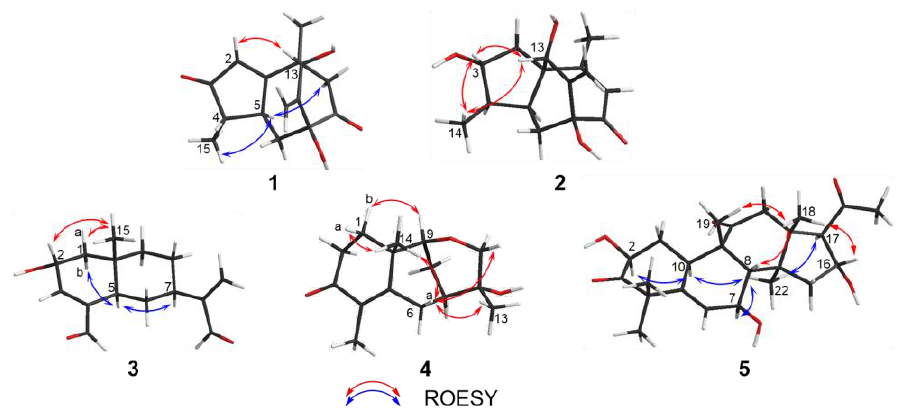
Figure 2. Key 1 H − 1 H COSY and HMBC correlations for 1 – 5 . Figure 2. Key 1 H− 1 H COSY and HMBC correlations for 1 – 5 . Figure 2. Key 1 H− 1 H COSY and HMBC correlations for 1 – 5 .